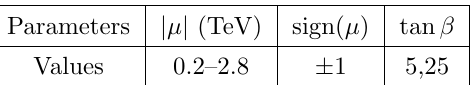
Table 1 . Relevant range of the input parameters for the parameter-space scan to study the decay probabilities of the lightest neutralino. Other parameters at (cid:12)xed values which include: M 1 = 4 TeV, M 2 = 4 TeV, M 3 = 2 : 9 TeV, M Q = 2 : 8 TeV, M U = 2 : 8 TeV, M A = 3 : 0 TeV, A t = 3 : 2 TeV and 3 3 m = 1 keV. e G